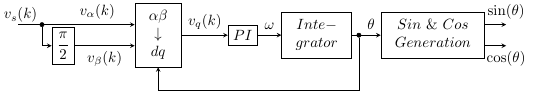
Figure 21. One-phase SRF-PLL.